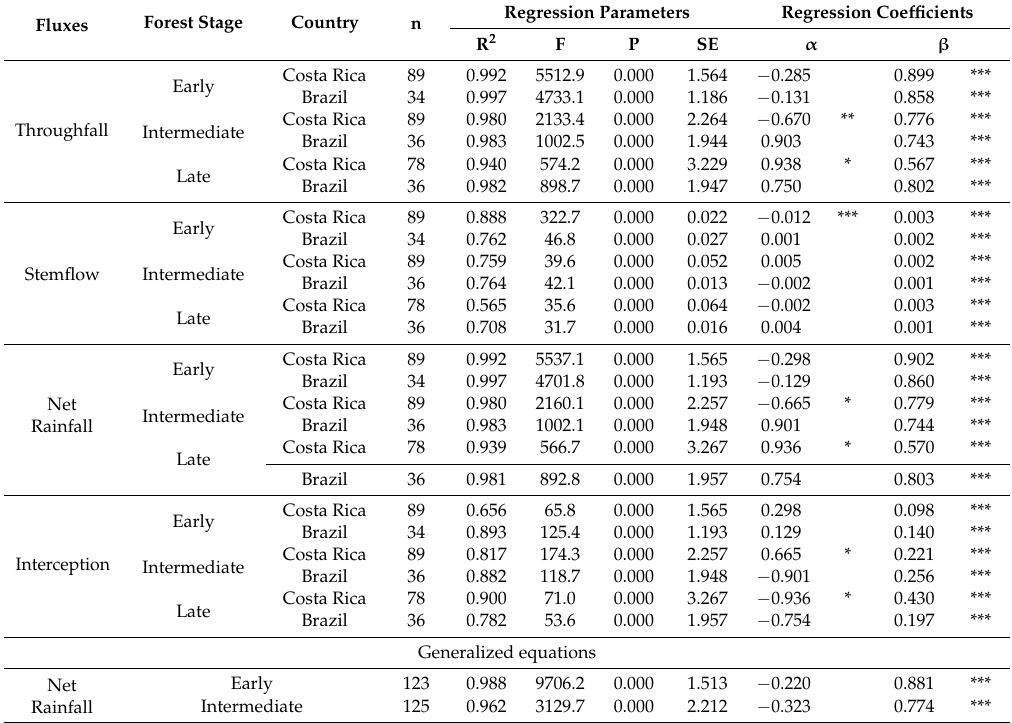
Table 3. Summary of the linear regression analyses of forest interception water fluxes in three successional stages of tropical dry forests in Costa Rica and